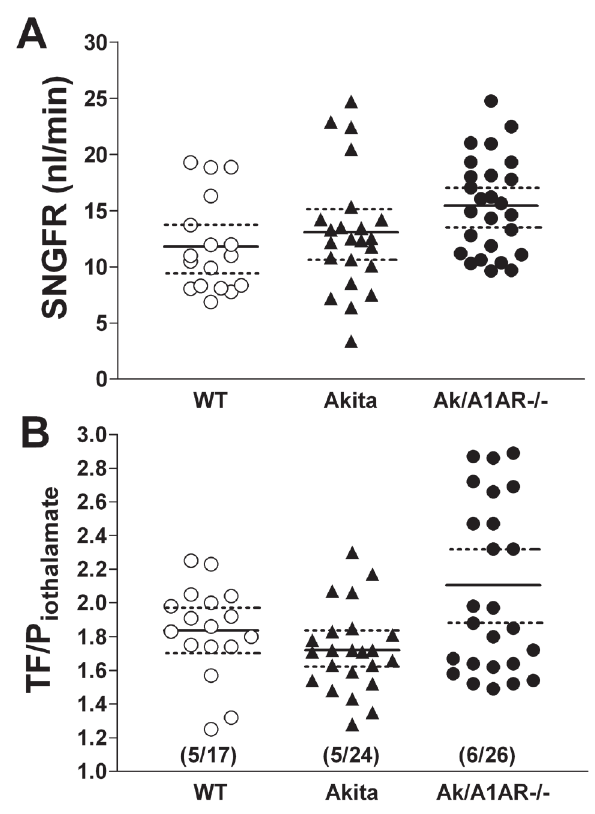
Figure 2. Measurements of proximal fluid reabsorption in wild type (WT), Akita, and Akita/A1AR-/- double mutant mice (Ak/ A1AR-/-). A : Fluid absorption rates in individual nephrons; solid lines are means, and broken lines are 95% confidence intervals. B : relationship between SNGFR and reabsorption rate; lines indicate linear